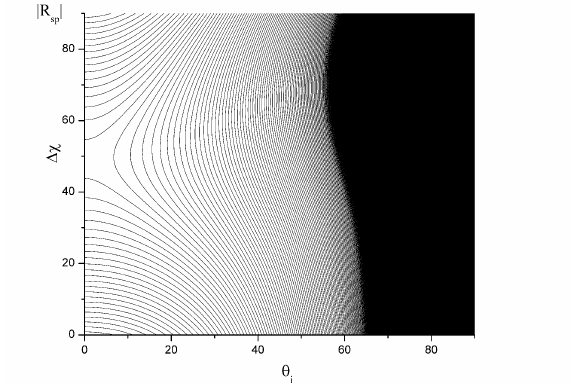
Fig. 6. The dependence of the modulus of the amplitude reflection coefficient R sp on the angle of  and the torsion angle  . incidence i